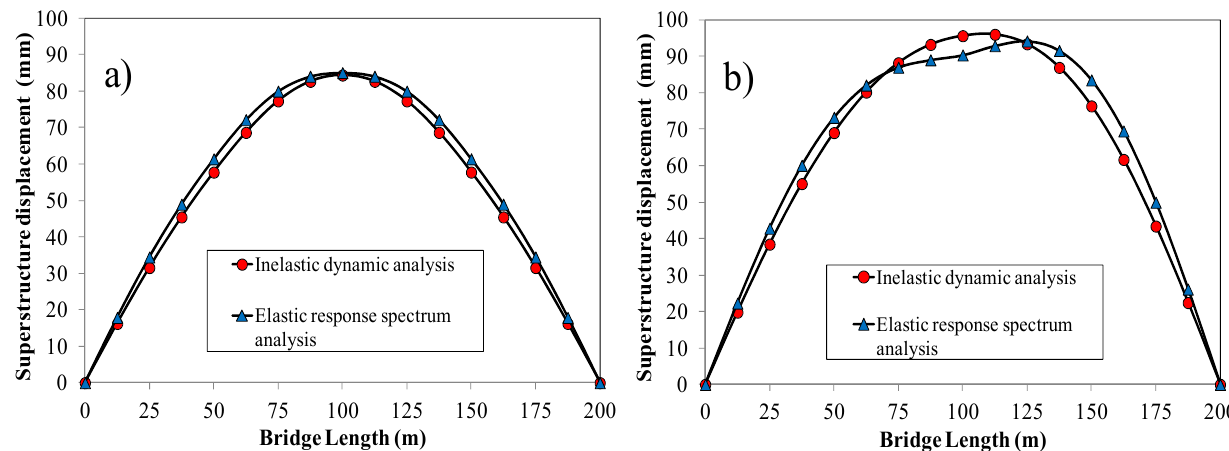
Figure 9. Transverse displacement envelopes obtained by means of 2D elastic and inelastic analyses for: ( a ) regular bridge ( b ) irregular bridge.